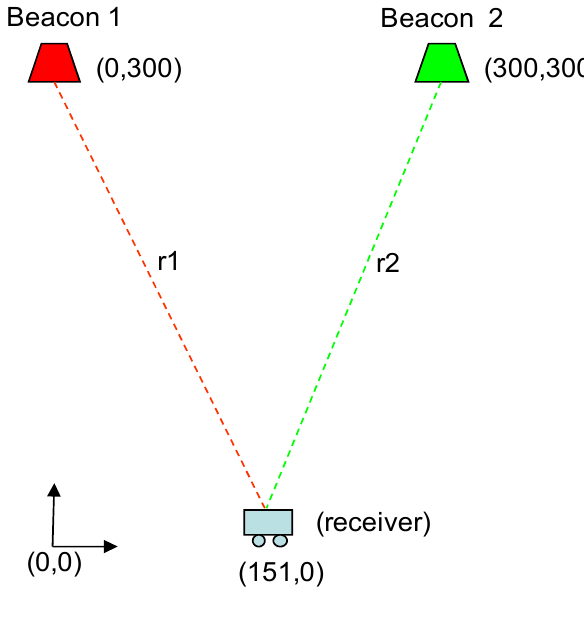
Figure 5. Position of the beacons and the receiver for the analysis of the detection